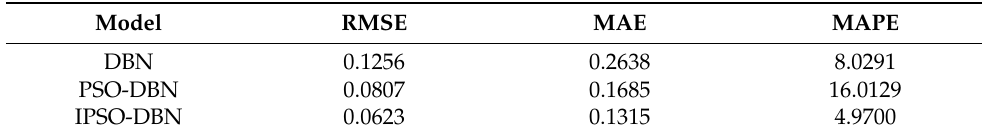
Table 4. Hidden layer neuron selection